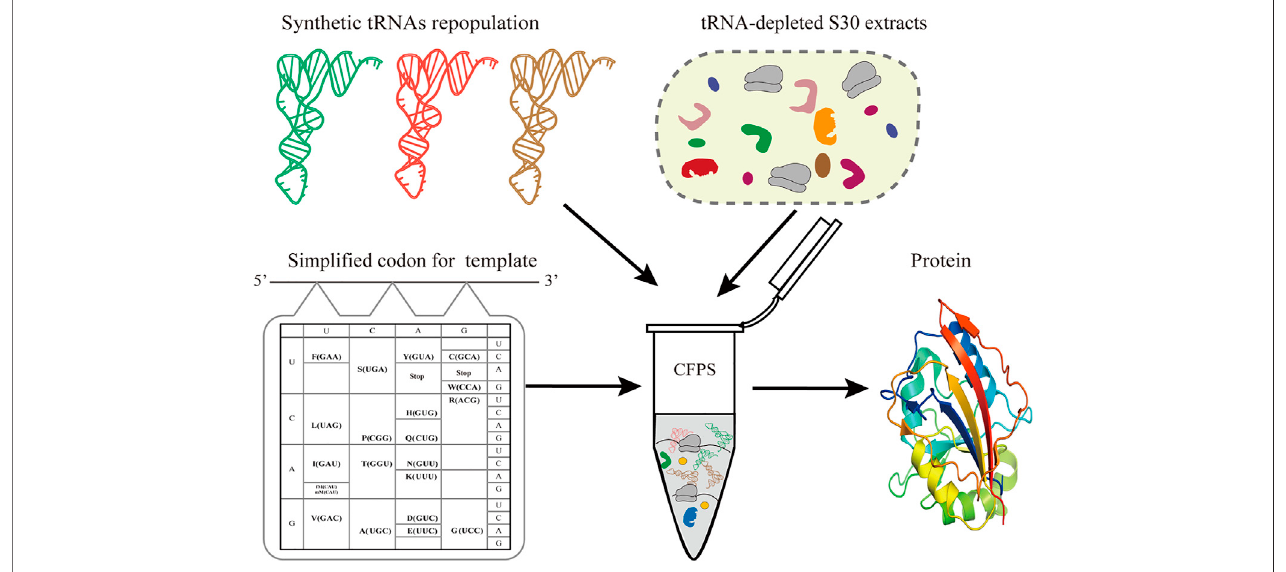
FIGURE 1 | Schematic of simpli fi ed codon protein synthesis in cell-free systems. In the sfGFP template, each amino acid is encoded by one codon and simultaneously decoded by one tRNA. In a tRNA-free CFPS system, the protein synthesis of sfGFP is performed by controlling the types and concentration of synthetic tRNAs according to the designed